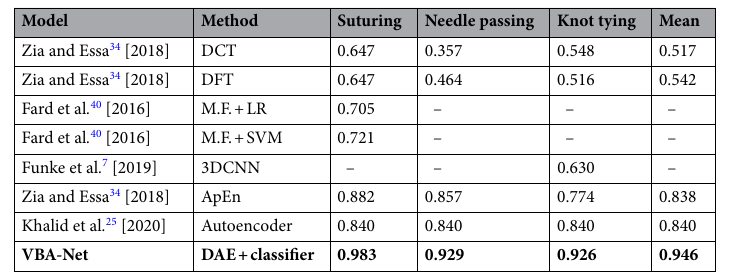
Table 1. Classification scores for LOUO CV. DCT discrete cosine transform, DFT discrete Fourier transform, LR logistic regression, SVM support vector machine, ApEn approximate entropy, M.F. manual features. Significant values are in